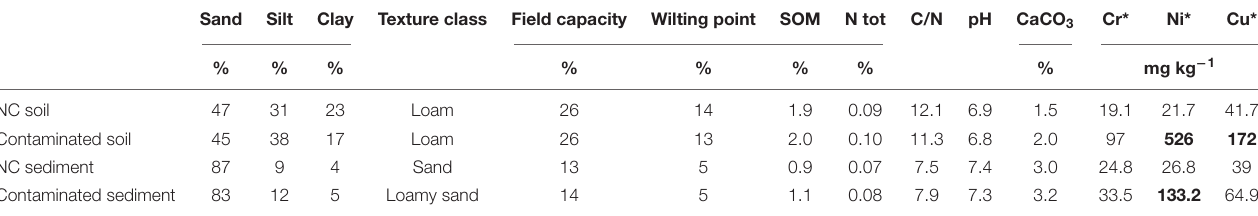
Bold values above the screening values are values established for residential soil use by the Italian Ministry of Environment (DM 152/2006). *Legislative limits currently adopted in Italy (DM 152/2006) for HM concentration in soil for green areas/residential use are respectively 150, 120, and 120 mg kg −